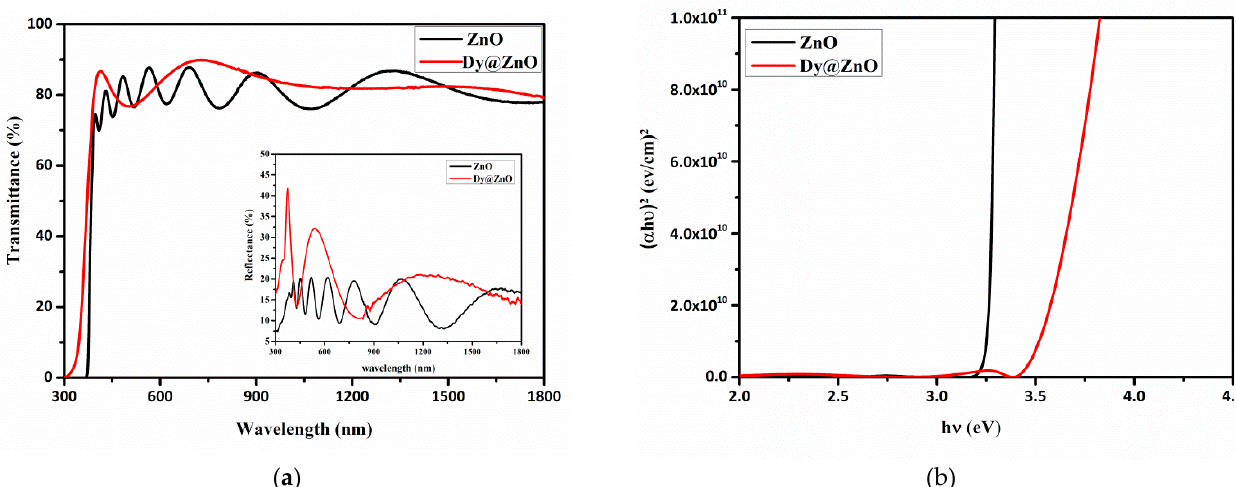
Figure 4. Optical transmittance and reflectance spectra for the Dy-doped ZnO thin films ( a ). The plot of ( α h ν ) 2 versus (h ν ) of undoped and Dy-doped ZnO thin films ( b ).